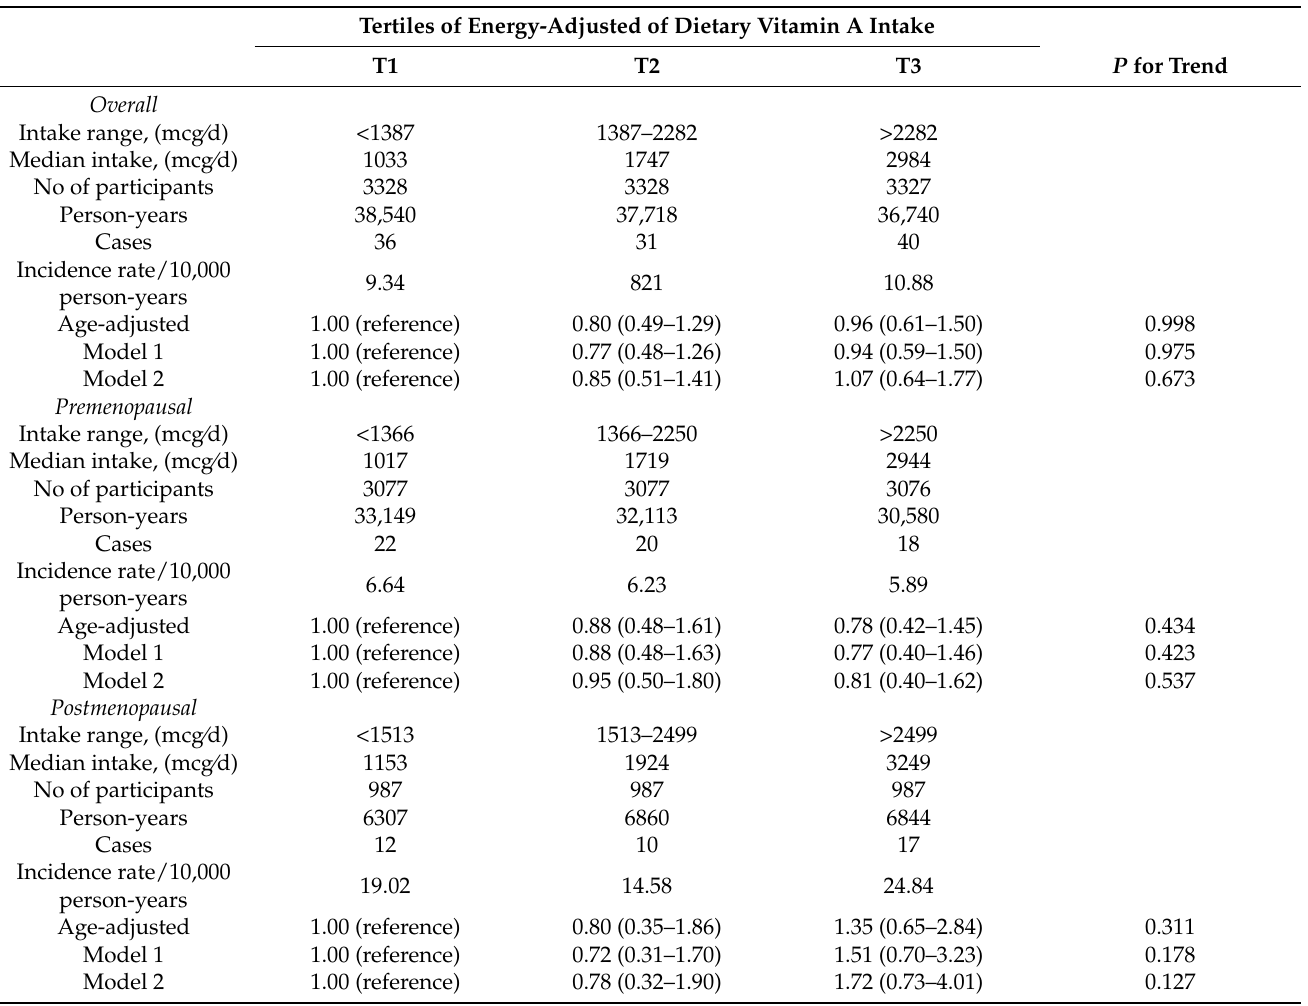
Table 2. Dietary vitamin A intake. Hazard Ratio (HR) and 95% Confidence Interval (CI) of breast cancer by tertiles of energy-adjusted dietary vitamin A at baseline among female participants of the SUN